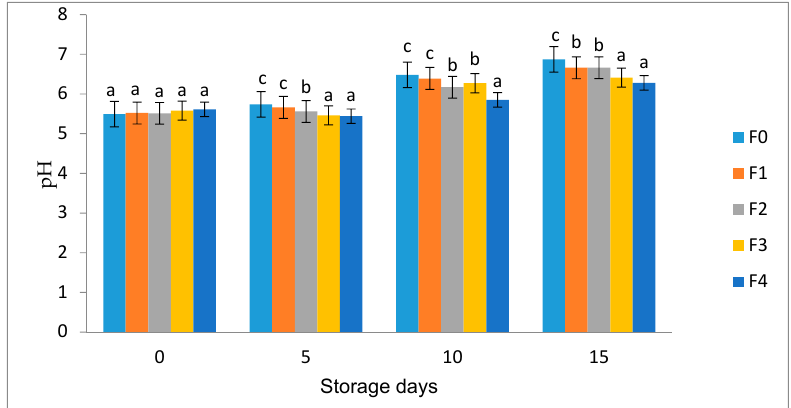
Figure 2. Effects of MOLP on pH of ground beef stored at 4 ± 1 °C for 15 days. Values are expressed as mean ± standard deviation. Means with different superscripts show significant differences among treatments within same storage day at p ≤ 0.05. F0 (100% ground beef), F1 (0.2%), F2 (0.4%), F3 (0.6%), and F4 (0.8%) Moringa oleifera leaves powder. According to Wapi et al. [54], meat with a pH greater than normal of 5.8 is more